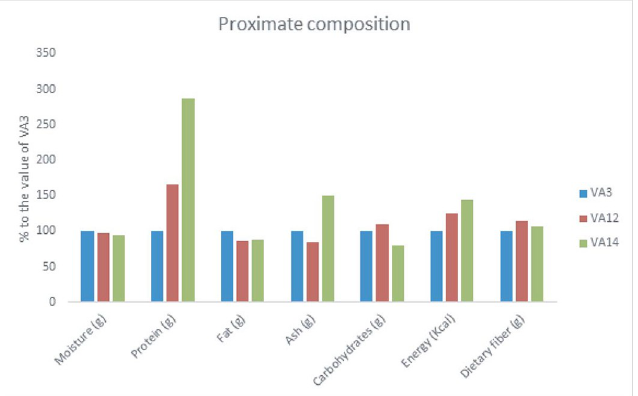
Fig 1. Influence of salinity on proximate composition (g 100 g -1 ) (% to the value of VA3) in three selected A . tricolor accessions.